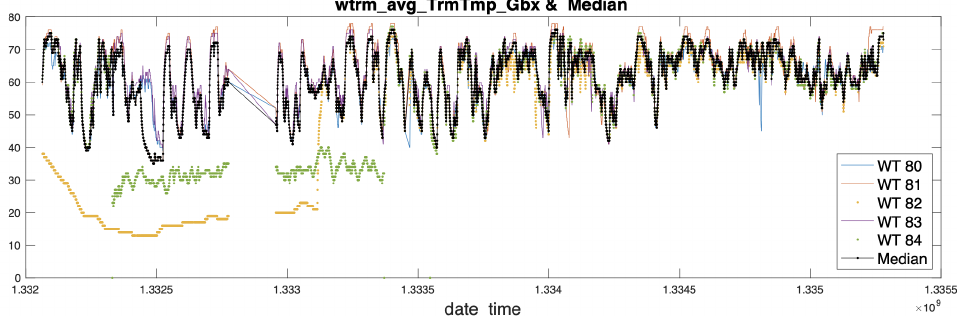
Figure 6. Reference signal (in black) of a fragment of the signals wtrm_avg_TrmTmp_Gbx after filtering out the